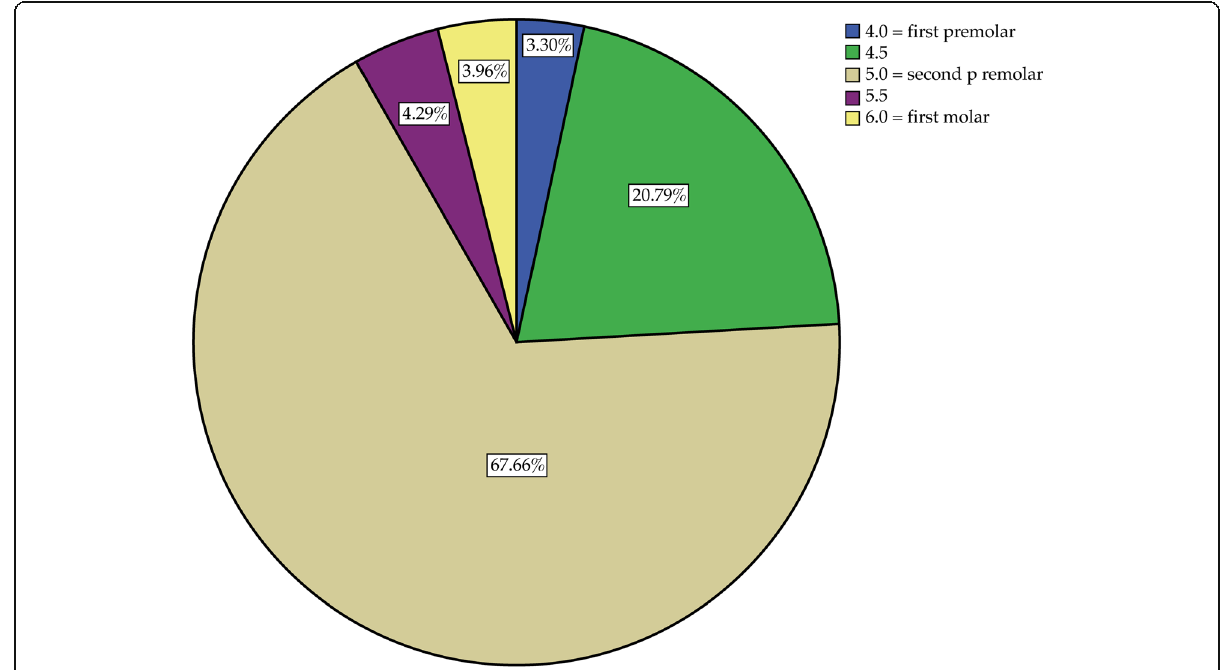
Fig. 5 Position of the left mental foramen